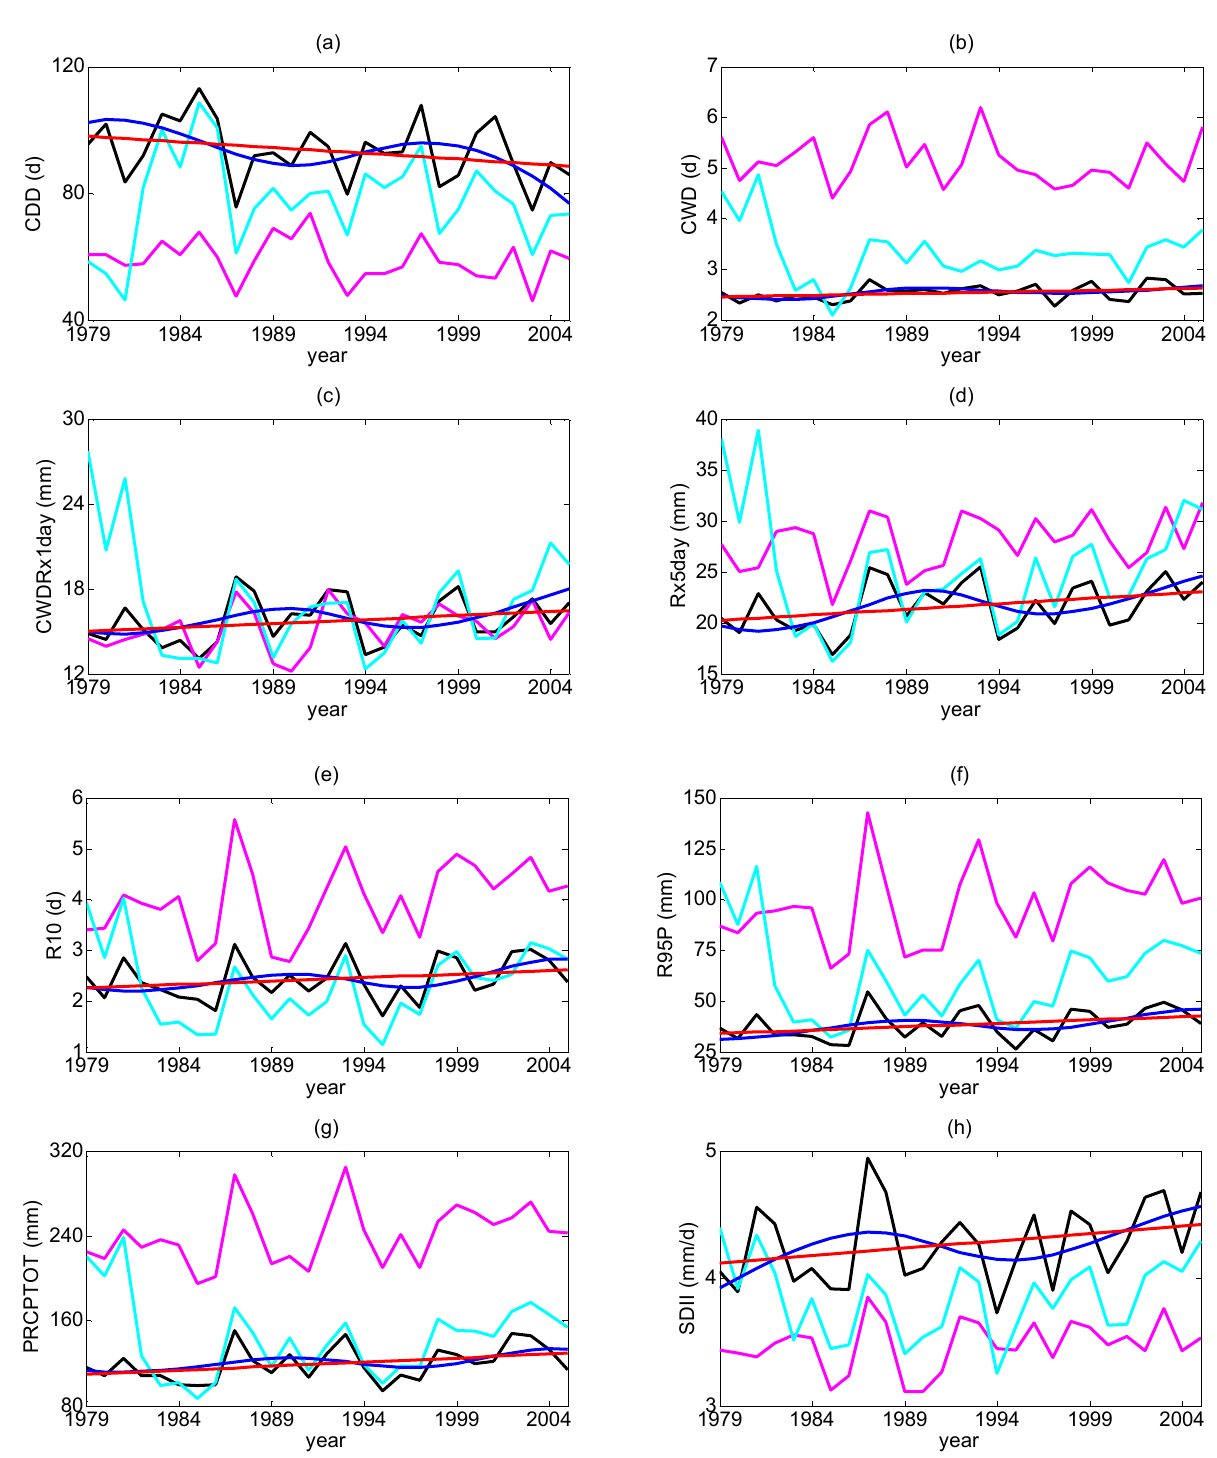
Figure 2. Annual precipitation indices series in CA during 1979–2005. Black, magenta, and cyan lines indicate OBS, ERA, and CPC, respectively. Red and blue lines indicate linear and nonlinear trends of OBS: ( a ) CDDs; ( b ) CWDs; ( c ) Rx1day; ( d ) Rx5day; ( e ) R10; ( f ) R95P; ( g ) PRCPTOT; ( h ) SDII.